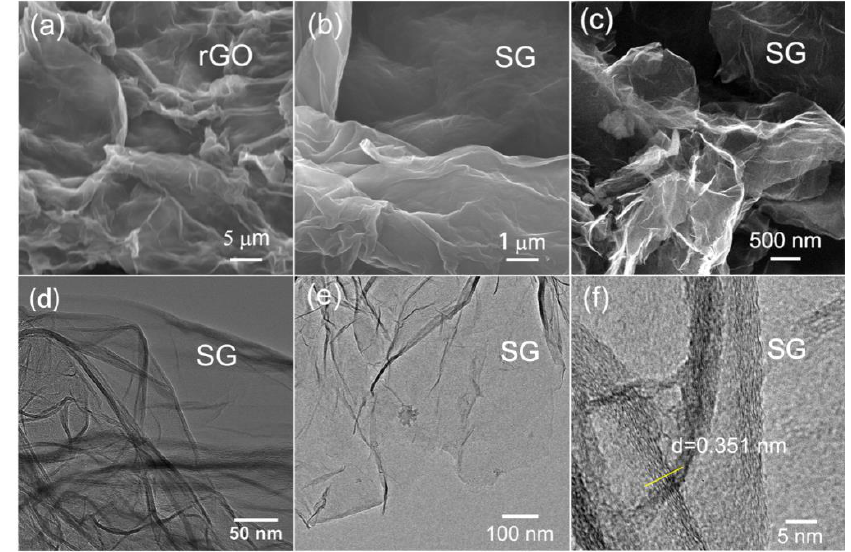
Figure 2. ( a ) Scanning electron microscope (SEM) image of rGO; ( b,c ) SEM images of SG; ( d,e ) Low-resolution transmission electron microscope (TEM) image of SG; ( f ) high-resolution TEM (HRTEM) image and lattice spacing of SG.